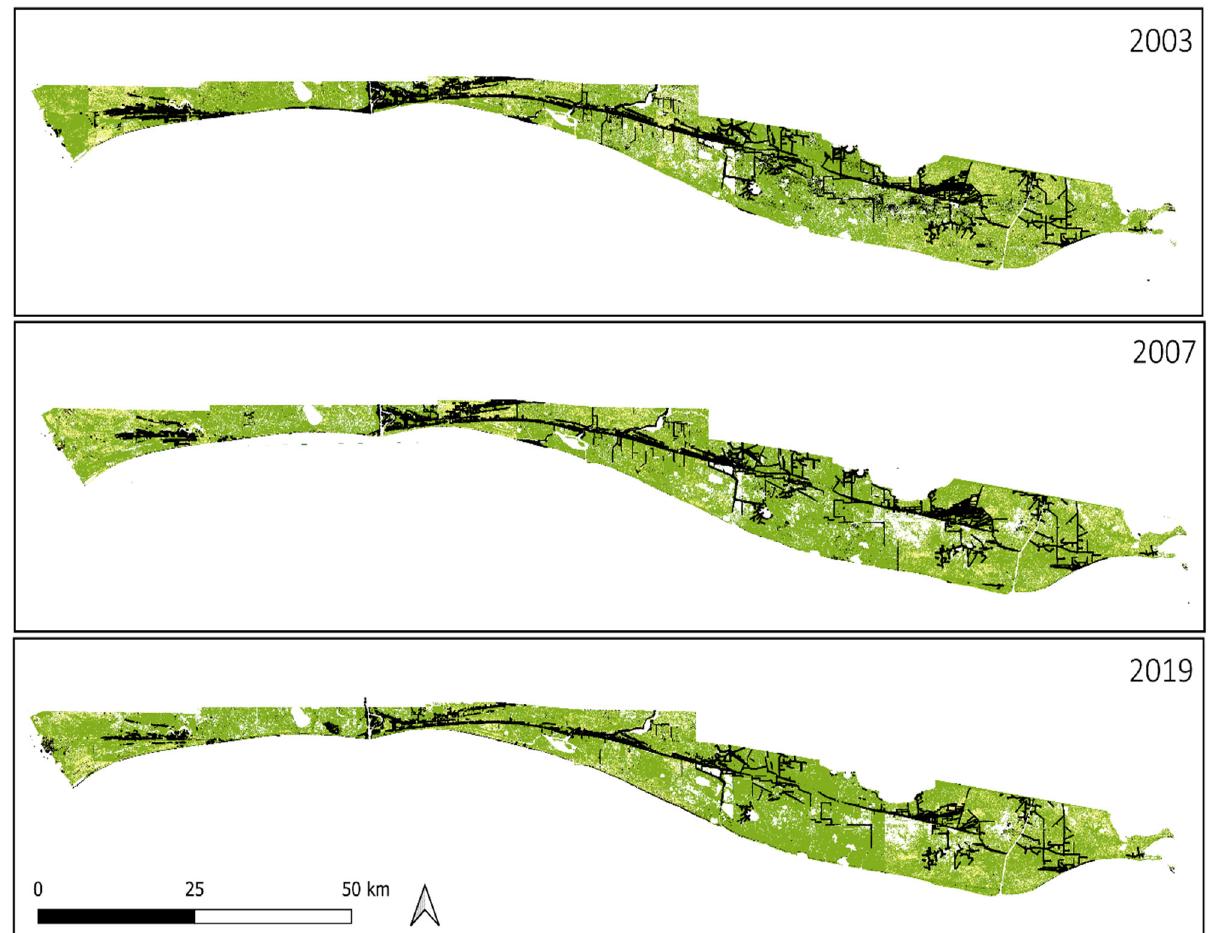
Figure 9. The total land area classified in GEE for the years 2003, 2007, and 2019. Light green represents the marsh area, tan represents pasture. The water layer has been removed for purposes of clarity. The dark black outline is the outline of the forest cover for the respective year.